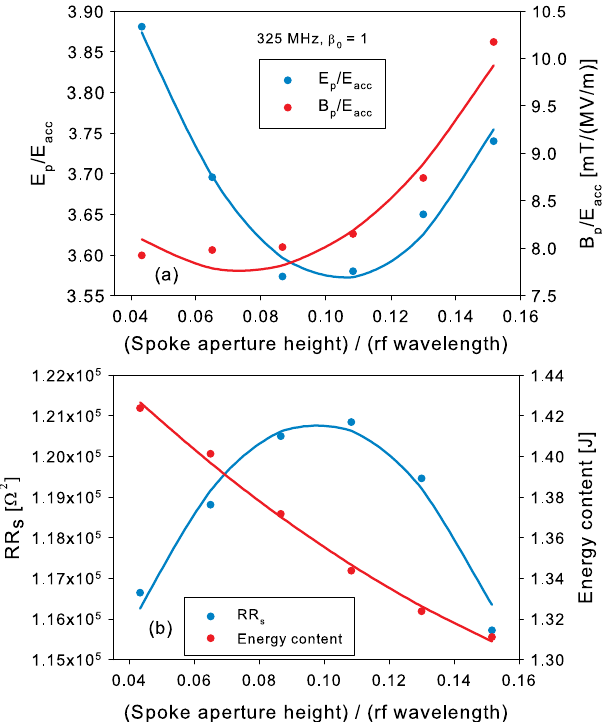
FIG. 17. Dependence of (a) E p =E acc and B p =E acc and (b) RR s and energy content (at 1 MV = m ) on spoke aperture height.